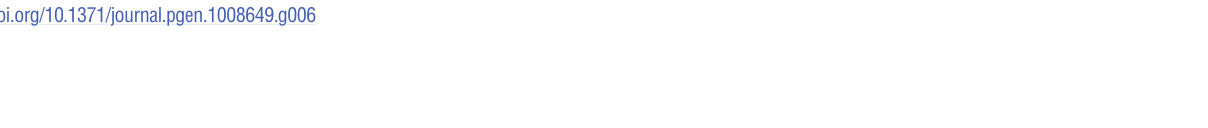
PLOS Genetics | https://doi.org/10.1371/journal.pgen.1008649 March 12,